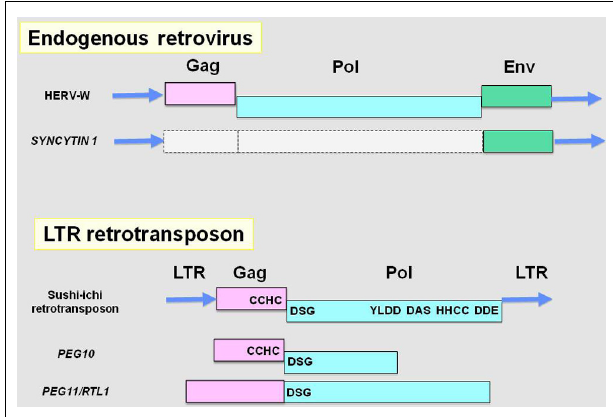
FIGURE 1 | Endogenous retrovirus, LTR retrotransposon and their domesticated genes. Top : an endogenous retrovirus, HERV-W, and SYNCYTIN 1 . SYNCYTIN 1 retains LTRs at both ends and the Env gene, while the Gag and Pol genes do not support ORFs corresponding functional proteins because of stop mutations. Bottom : an LTR retrotransposon, sushi-ichi, and the domesticated PEG10 and PEG11/RTL1 genes. Both PEG10 and PEG11/RTL1 have lost LTRs while entire regions exhibit significant homologies to the Gag and Pol genes remaining in some of the retrotransposon domains.The − 1 frameshift mechanism is conserved in PEG10. LTR, long terminal repeat; Gag, group-specific antigen; Pol, polymerase; Env, envelope; CCHC, RNA-binding motif; DSG, protease active site;YYDD, reverse transcriptase; DAS, RNase highly conserved motif; HHCC, integrase DNA binding motif; DDE, strongly conserved